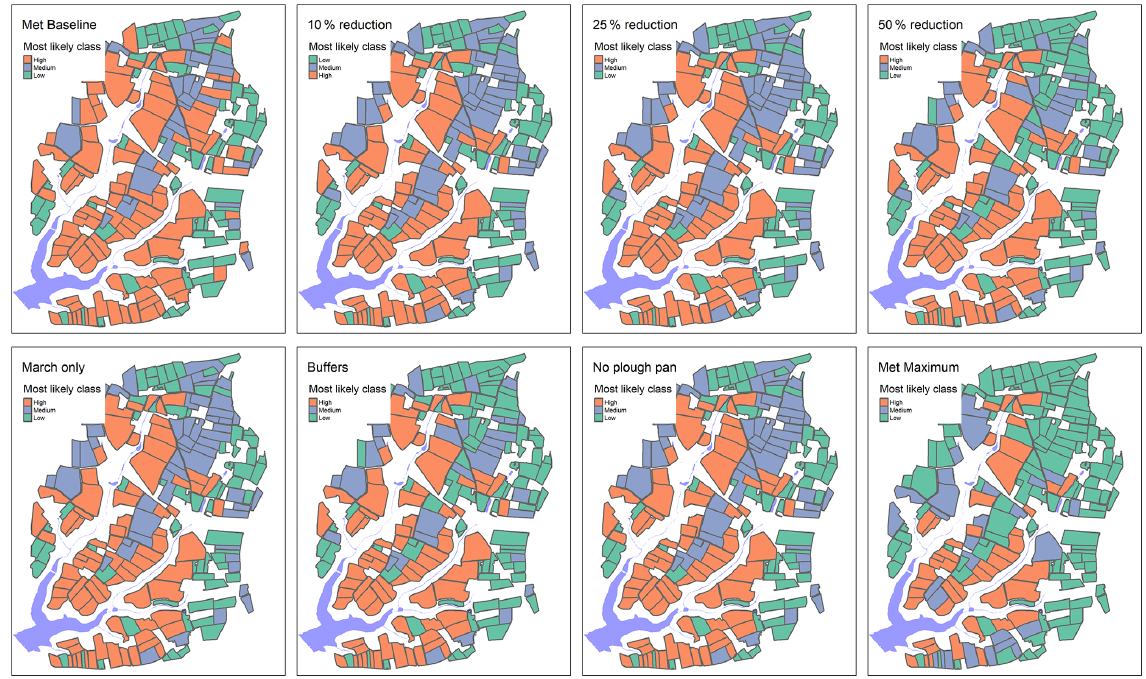
Figure 8. Example output showing the most likely overland flow risk class for each field for metobromuron under current (baseline) ap- plication practices; with a 10%, 25%, or 50% reduction in application; with a time shift of application to March; with additional field buffers; with no plough pan; and with a combination of all available mitigation measures (shifting application to March, a 50% reduction in application rates, buffers, and no soil